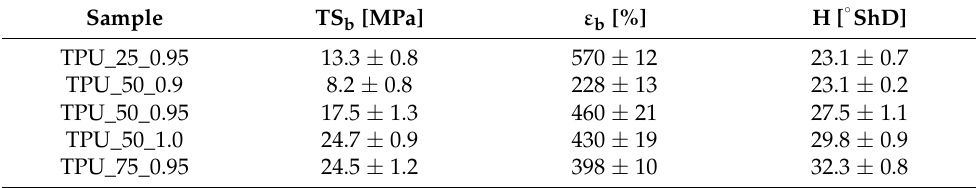
Table 5. The results of selected mechanical properties of the prepared green TPUs.